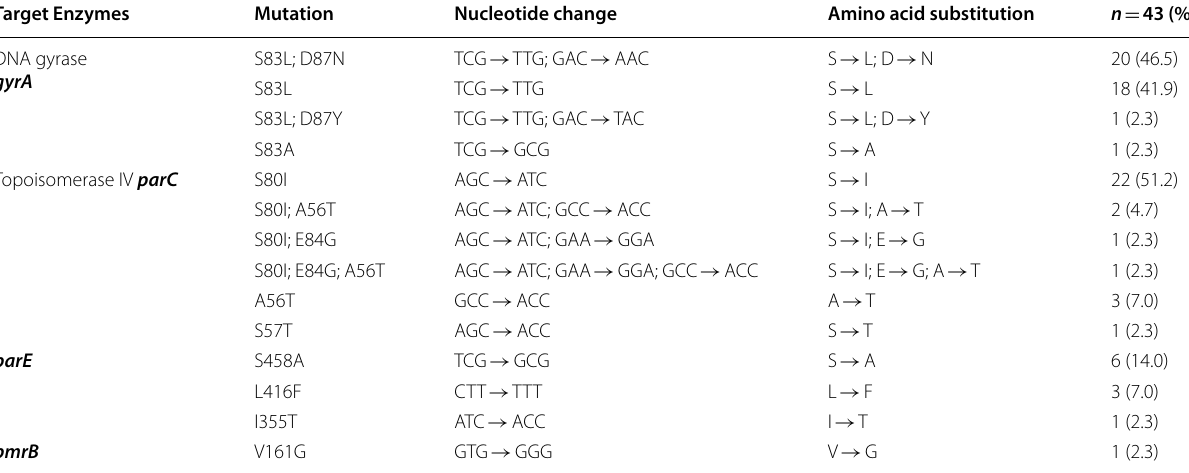
Table 5 Distribution of substitutions in topoisomerase subunits detected in 43 PMQR Escherichia coli isolates from humans, chickens and poultry farm/market